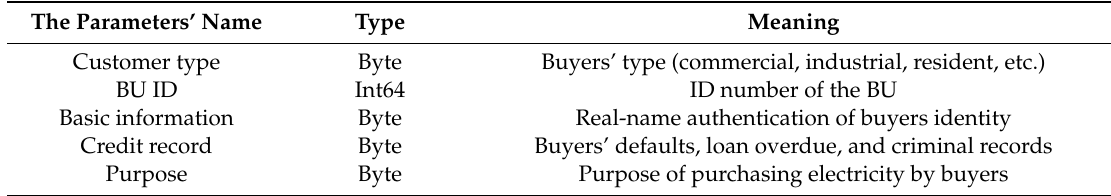
Table 1. Basic elements of authentication unit chaincode for the BU.